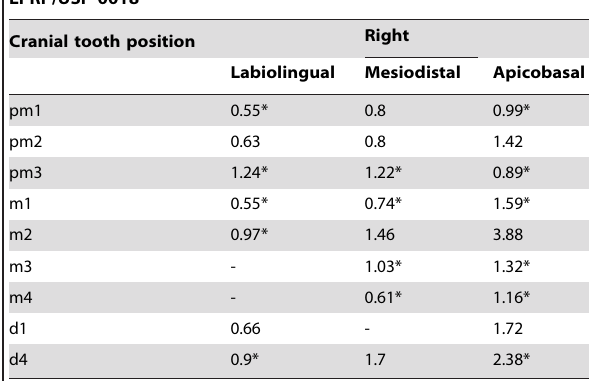
Table 4. Maximum labiolingual and mesiodistal diameters, and apicobasal length (in cm) of premaxillary (pm), maxillary (m) and dentary (d) tooth crowns of LPRP/USP